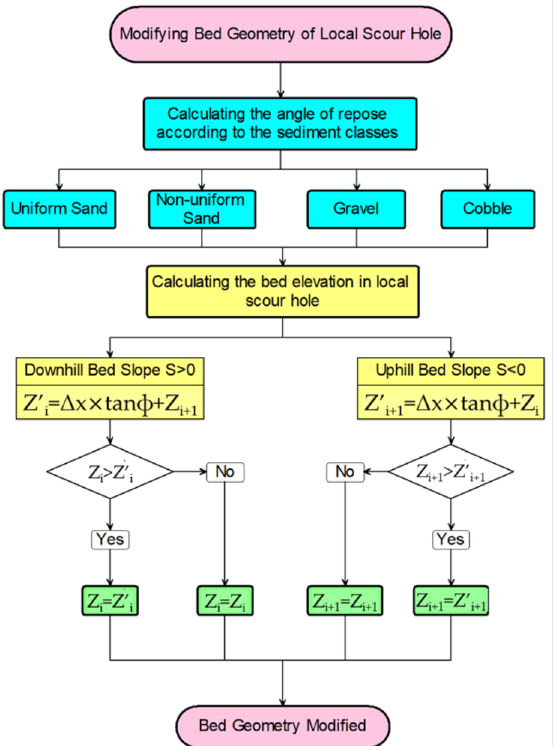
Figure 5. Flowchart of the bed geometry adjustment mechanism of a local scour hole.